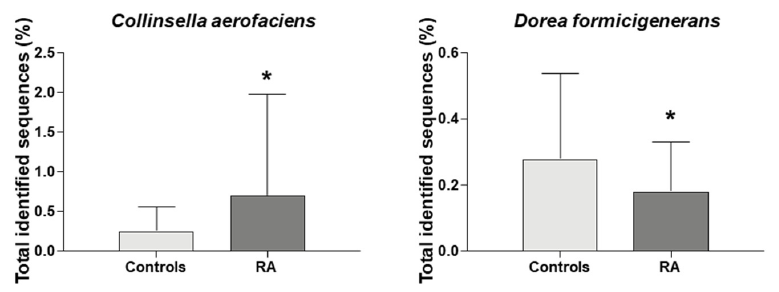
Figure 3. Microbial composition at species level of Collinsella aerofaciens and Dorea formicigenerans * indicates significant differences vs. controls ( p - value ≤ 0.05). RA, Rheumatoid arthritis.